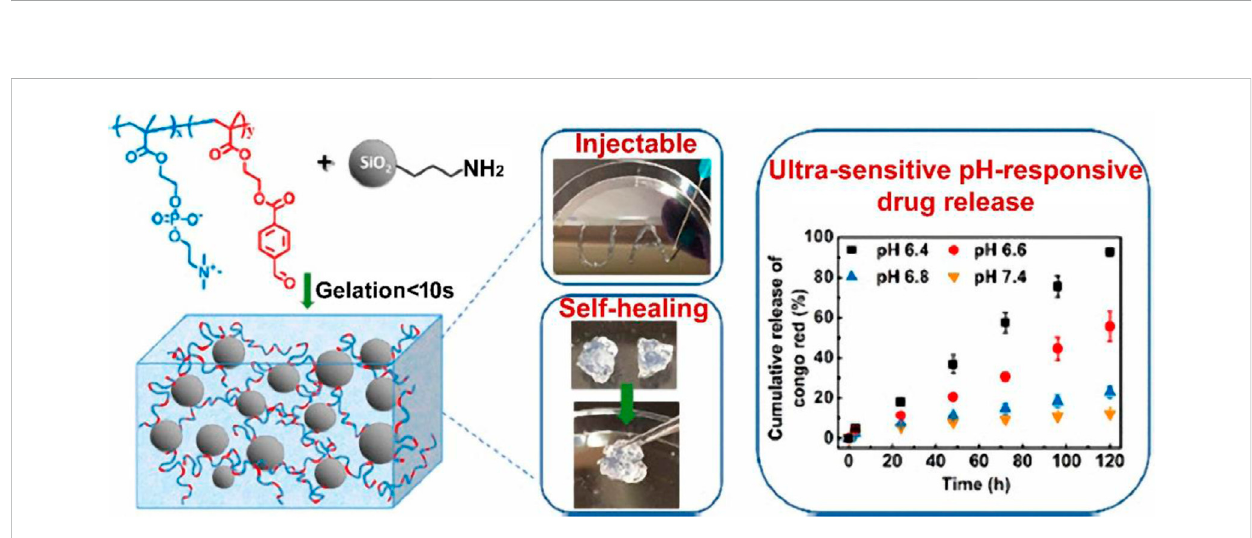
FIGURE 6 Illustration of injectable and self-healing nanocomposite hydrogels with ultrasensitive pH-responsiveness and tunable mechanical properties. Reprinted with permission from (Wu et al., 2020). Copyright 2020 American Chemical